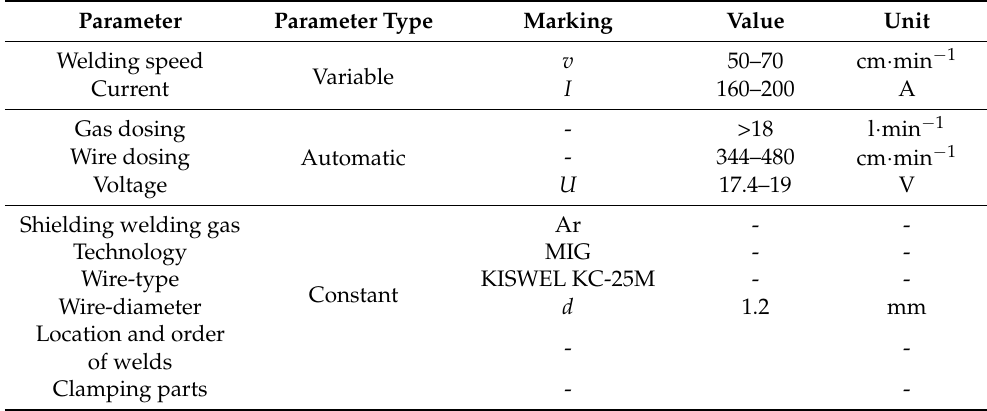
Table 2. Welding